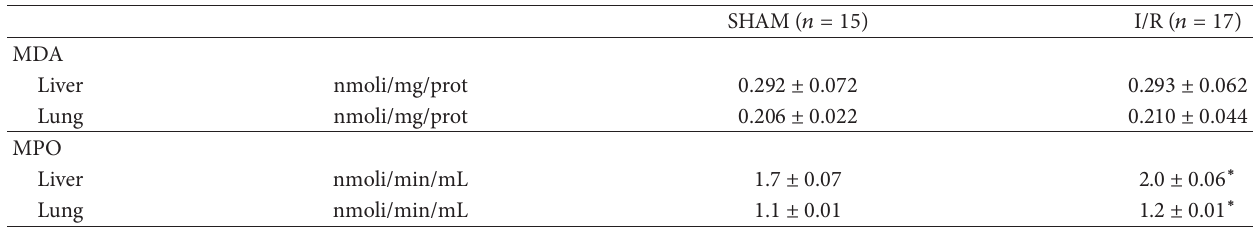
Table 2: Liver and lung levels of MDA and MPO in animals submitted to ischemia/reperfusion (I/R). Sham-operated group (control) has been compared with I/R group: ∗ 𝑃 < 0.05 . These are the mean results of 32 different experiments ± S.E.M.